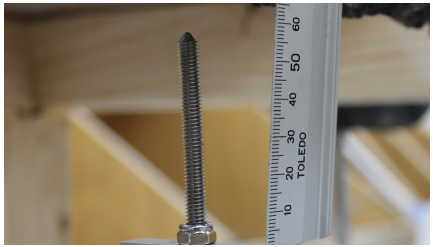
Figure 3. The penetrometer